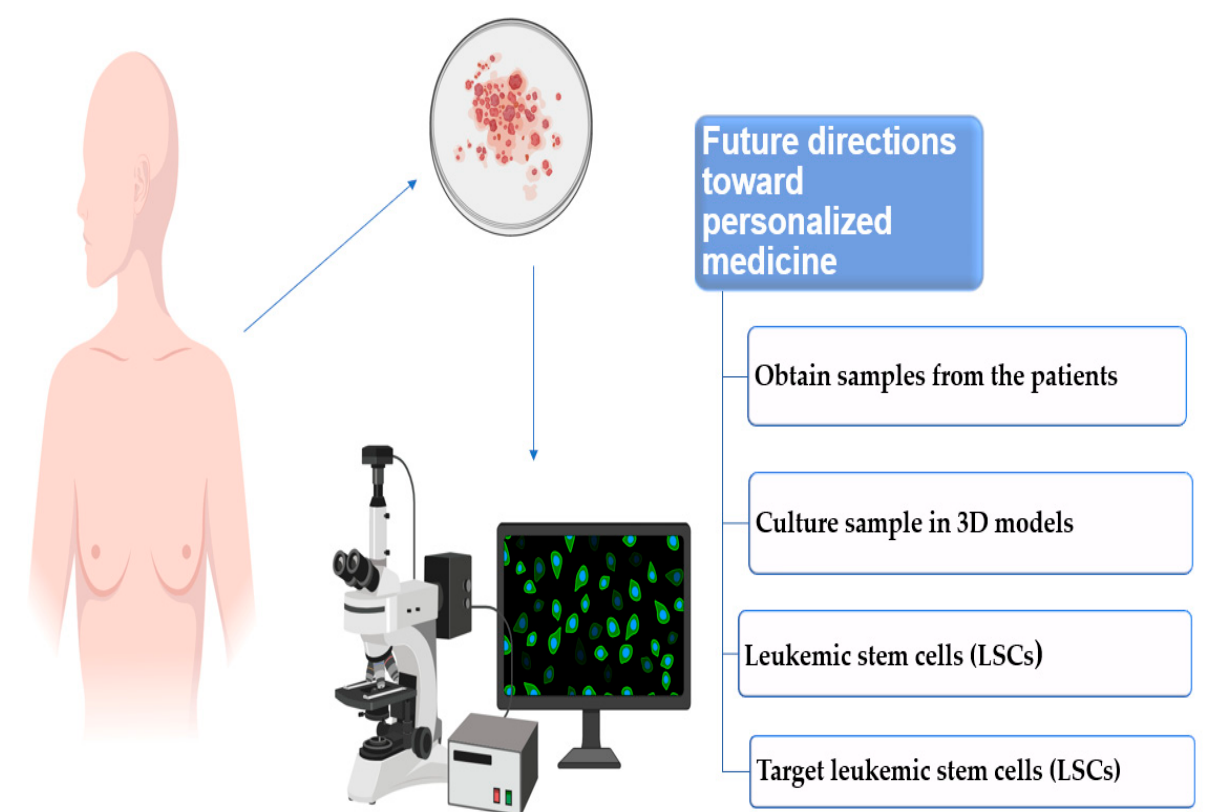
Figure 1. Proposed algorithm of the future utilization of in vitro 3D models in treating AML.